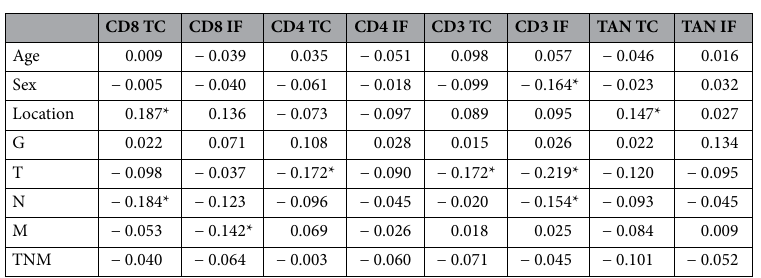
Table 5. Spearman’s rank correlation coefficients between selected tumor-infiltrating immune cells and clinicopathological parameters. Marked correlation coefficients are significant with p < 0.05.